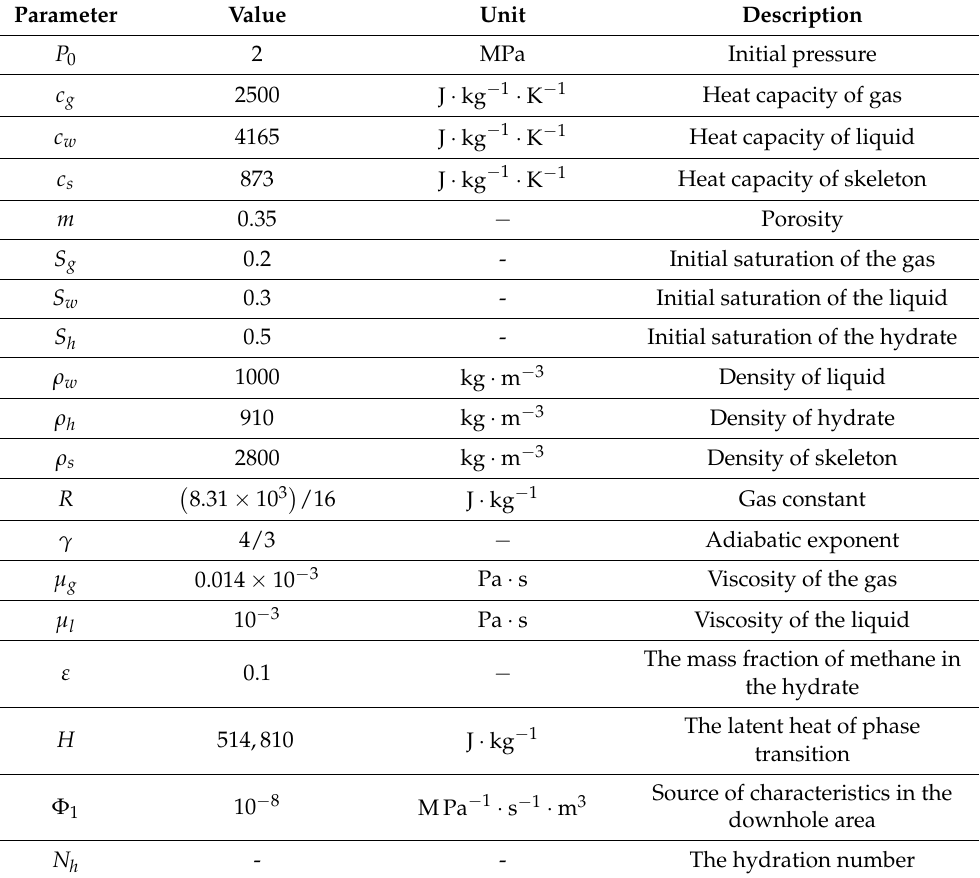
Table 1. The physical parameters and values used in our calculations [32,35]. Parameter Value Unit Description P 0 2